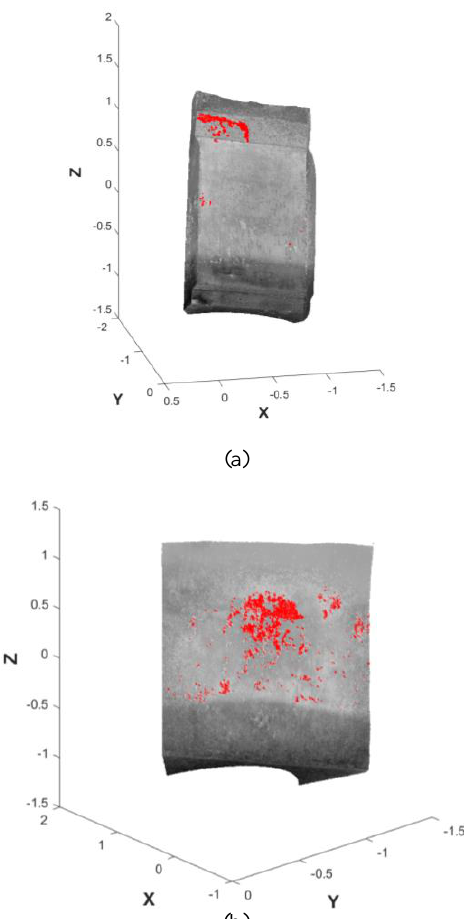
Figure 13. Damage areas visualization in 3D point clouds: (a) Wall 1; (b) wall